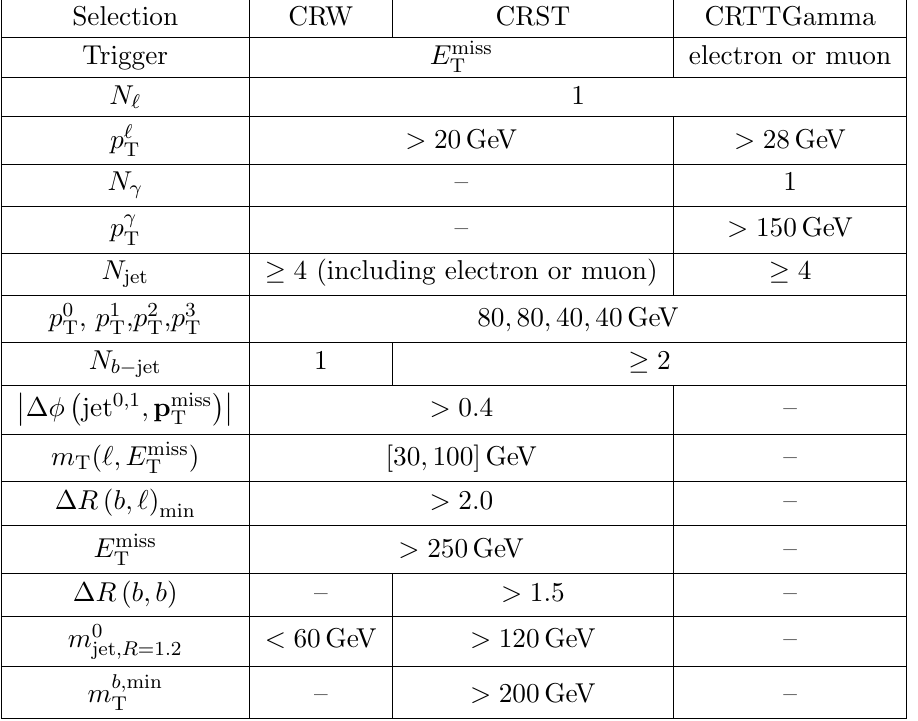
Simultaneous (cid:12)t to determine SM